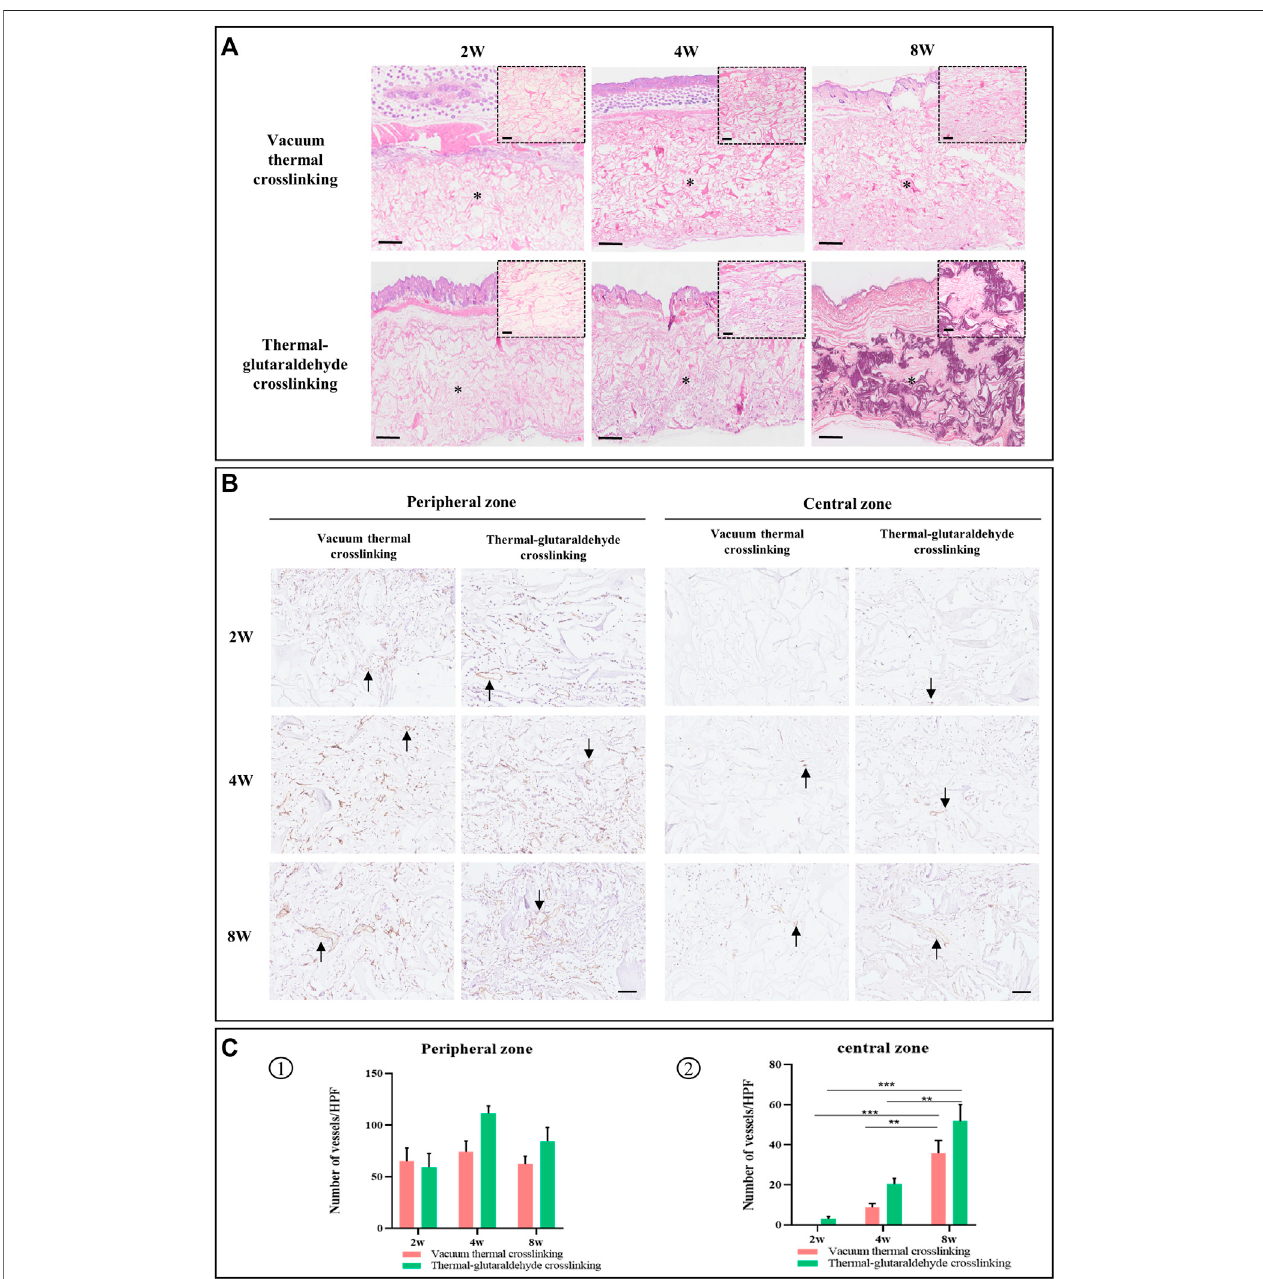
FIGURE 6 | Histopathological observation. (A) HE staining. The small picture in the top corner is the local enlarged view to display clearly. Bar in the big picture = 500 μ m, bar in the small picture = 100 μ m (the M character indicates material). (B) Immunohistochemical staining for CD31 in materials, and black arrow points new vessels, bar = 100 μ m. (C) Statistical analysis on the number of vessels in the peripheral zone and the central zone at 2w, 4w, and 8w ( n = 3 for each group). *p < 0.05 , **p < 0.01 , ***p < 0.001 , and ****p < 0.0001.